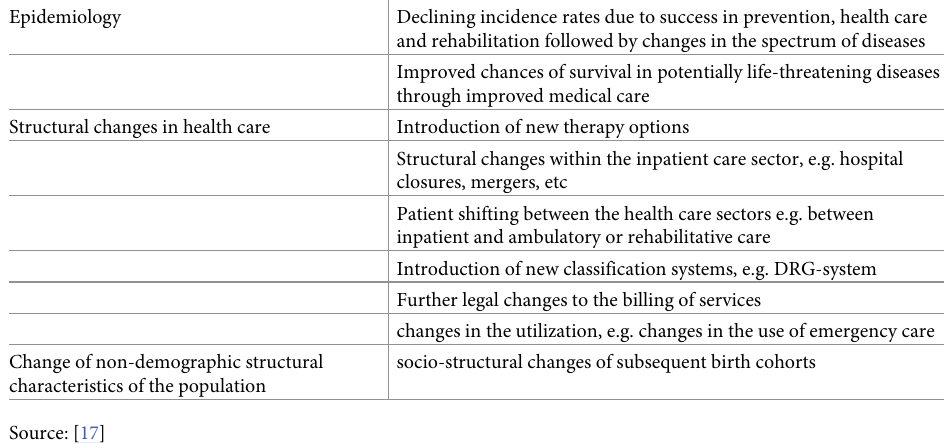
Table 1. Compilation of trends underlying the non-demographic